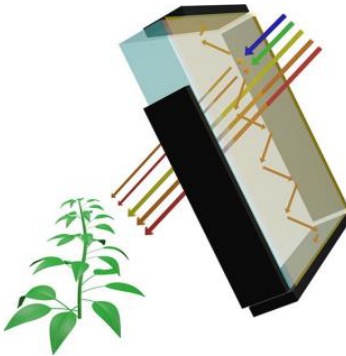
Figure 4. High Concentrator PV with diffused light used for plant growth; source: Reprinted with permission [40]. Copyright {2021}.